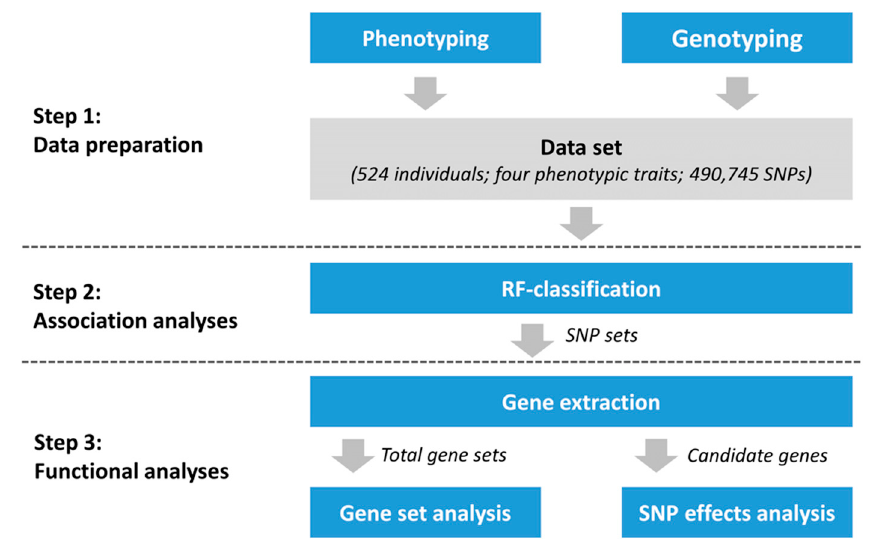
Figure 1. Schematic illustration of the study design. The data set included 524 laying hens phenotyped for bone stability traits. The corresponding genotypes included 490,745 SNP markers. Association analysis was performed applying Random Forests (RF) classification. Genes harbouring significant SNPs were extracted and screened for links to bone stability. Gene set analyses were performed considering all genes obtained from the RF classification. Retrospectively, SNP effects were estimated for a subset of candidate genes identified in gene sets obtained from the RF classifier.